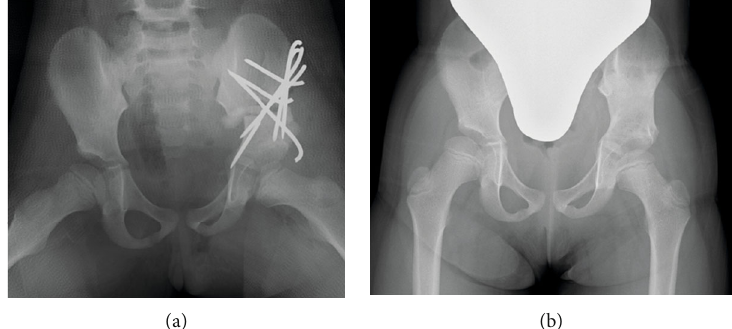
Figure 4: (a) The radiograph just after the additional surgery. (b) The radiograph of the hips at the last follow-up.